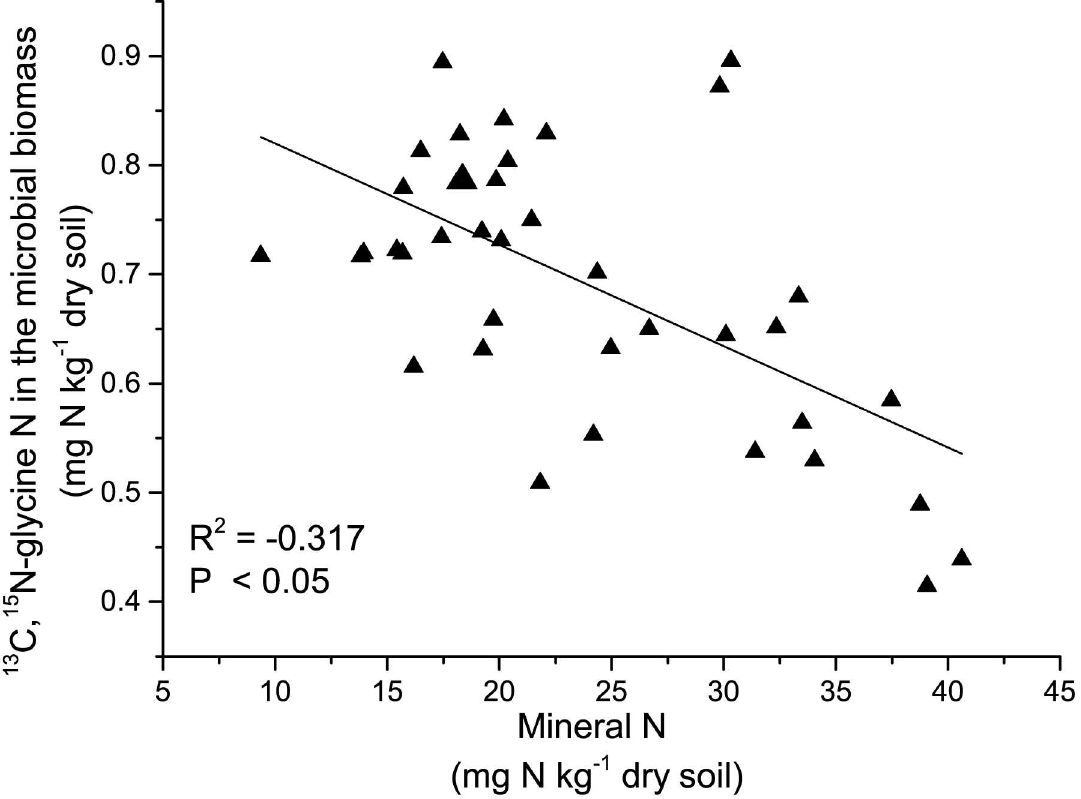
Fig 5. Correlation between 13 C, 15 N-glycine in the microbial biomass and soil mineral N.